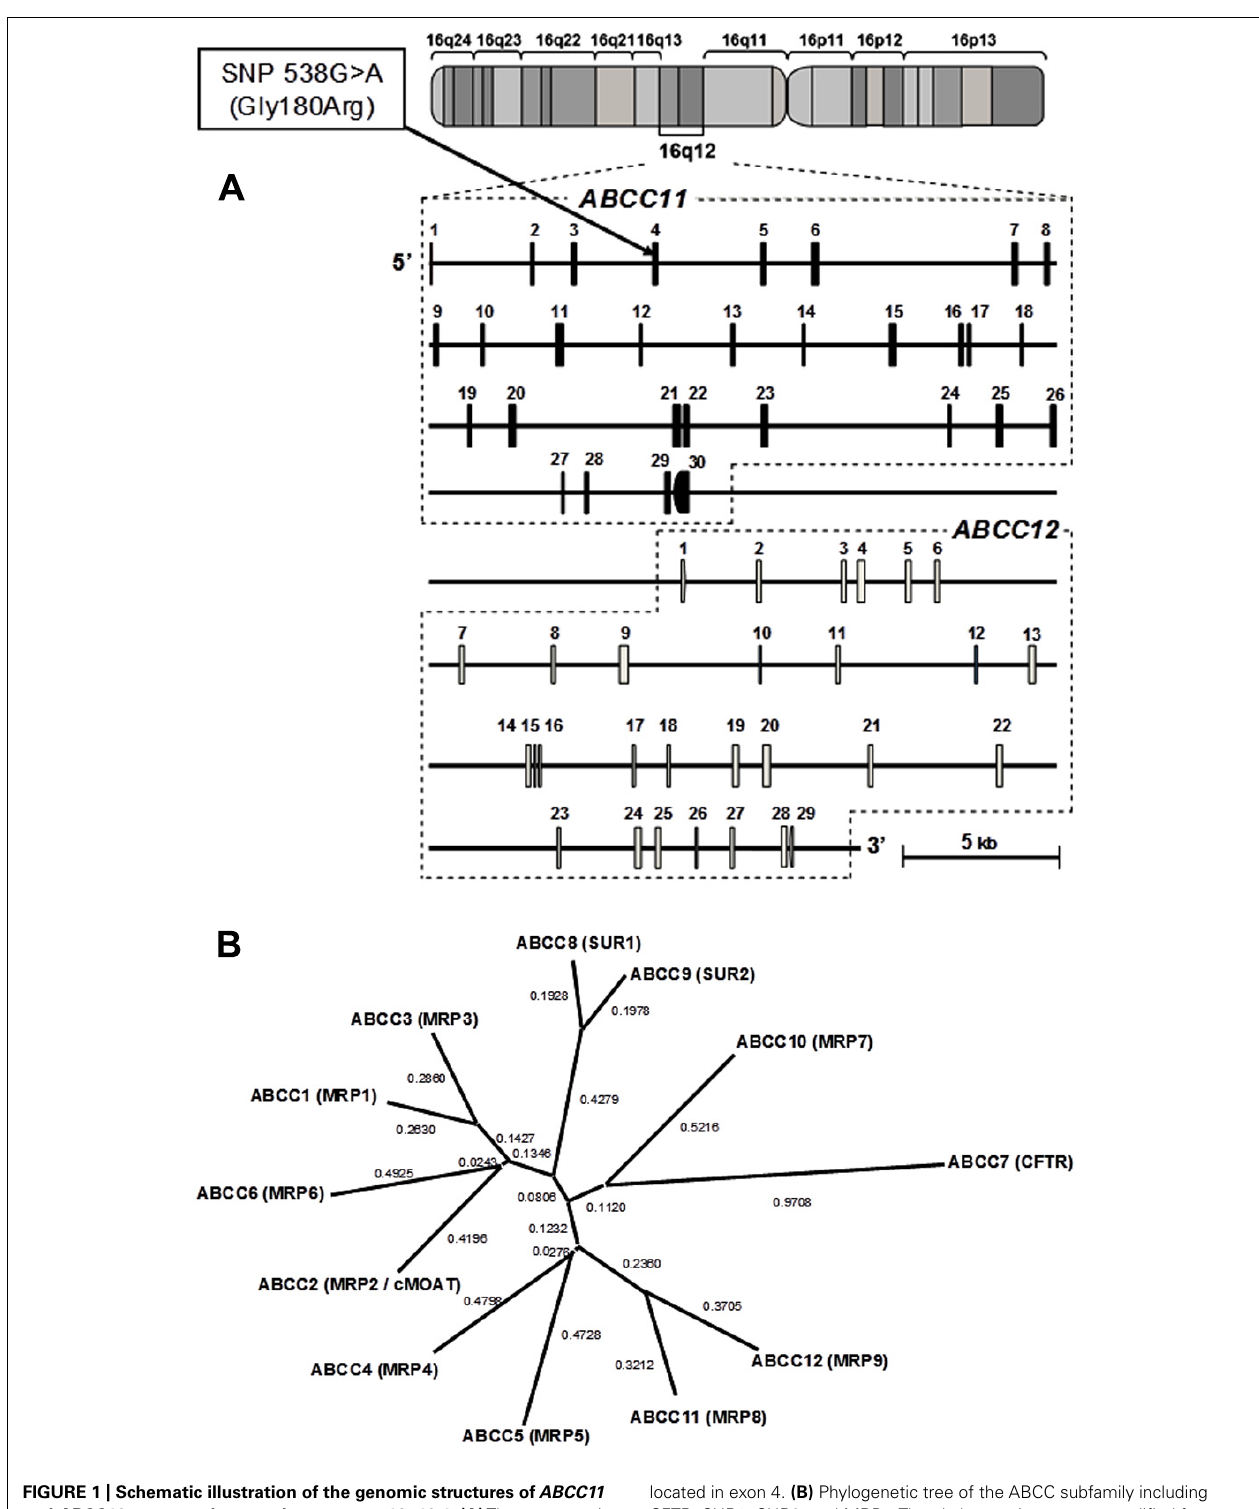
FIGURE 1 | Schematic illustration of the genomic structures of ABCC11 and ABCC12 genes on human chromosome 16q12.1. (A) The cytogenetic location of the ABCC11 gene as well as the structures of exons and introns were analyzed by BLAST searches on the human genome. A non-synonymous SNP: 538G > A (Gly180Arg), an earwax determinant, is